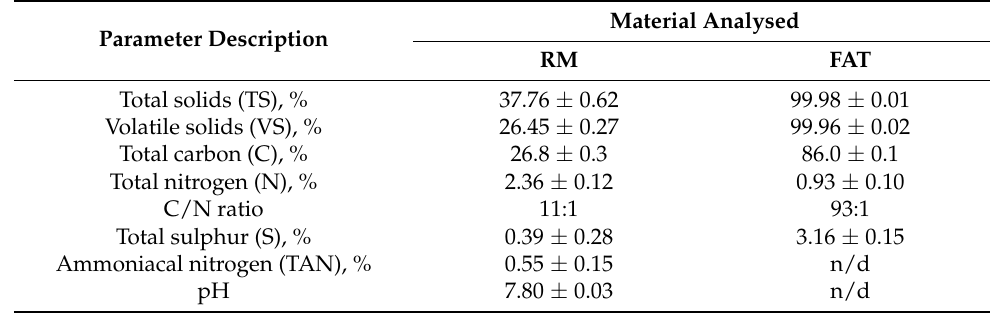
Table 2. Physical and chemical parameters of raw material (wet matter basis). Parameter